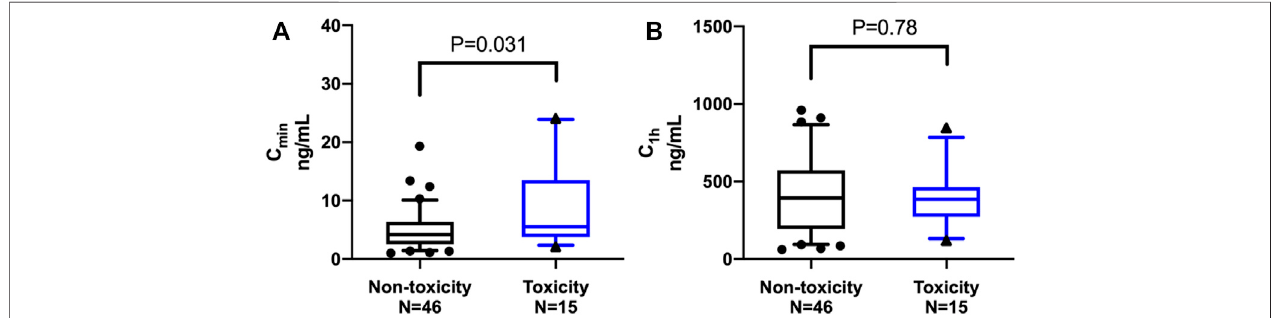
FIGURE 2 | Comparison of lenalidomide plasma concentrations between the groups. The middle line represents the median in each group. (A) The trough concentration (C min ), expressed as the median (IQR), was signi fi cantly higher in the toxicity group than in the non-toxicity group [5.53 (3.97 – 13.05) ng/mL versus 4.17 (1.03 – 6.33)ng/mL; p= 0.031]. (B) Theplasmaconcentrationat1 h(C 1h )afteroraladministration,expressedasthemean(SD),showednosigni fi cantdifferencebetween the toxicity group and the non-toxicity group [396.67 (206.73) ng/mL versus 416.98 (254.05) ng/mL; p = 0.78].